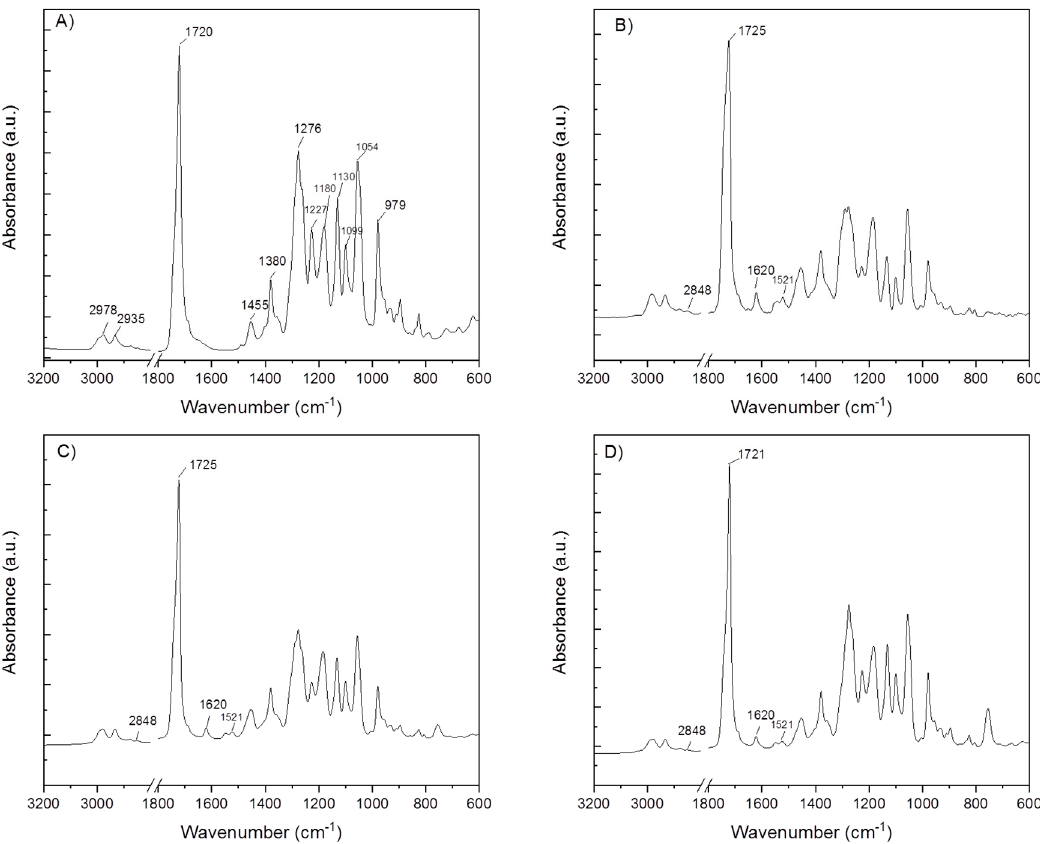
Figure 4. FT-IR spectra of electrospun samples: ( A ) neat PHB, ( B ) EM_1_L, ( C ) EM_4_L, ( D ) EM_5_L.